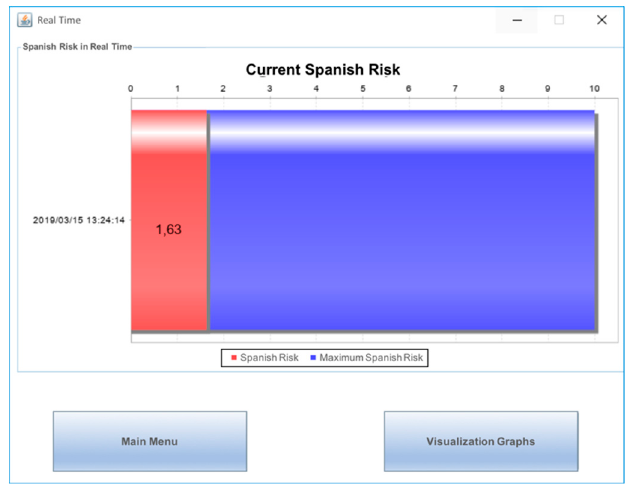
Figure 12. Real-time visualization of the global risk of Spain. The current risk is shown in red over a maximum possible in blue.